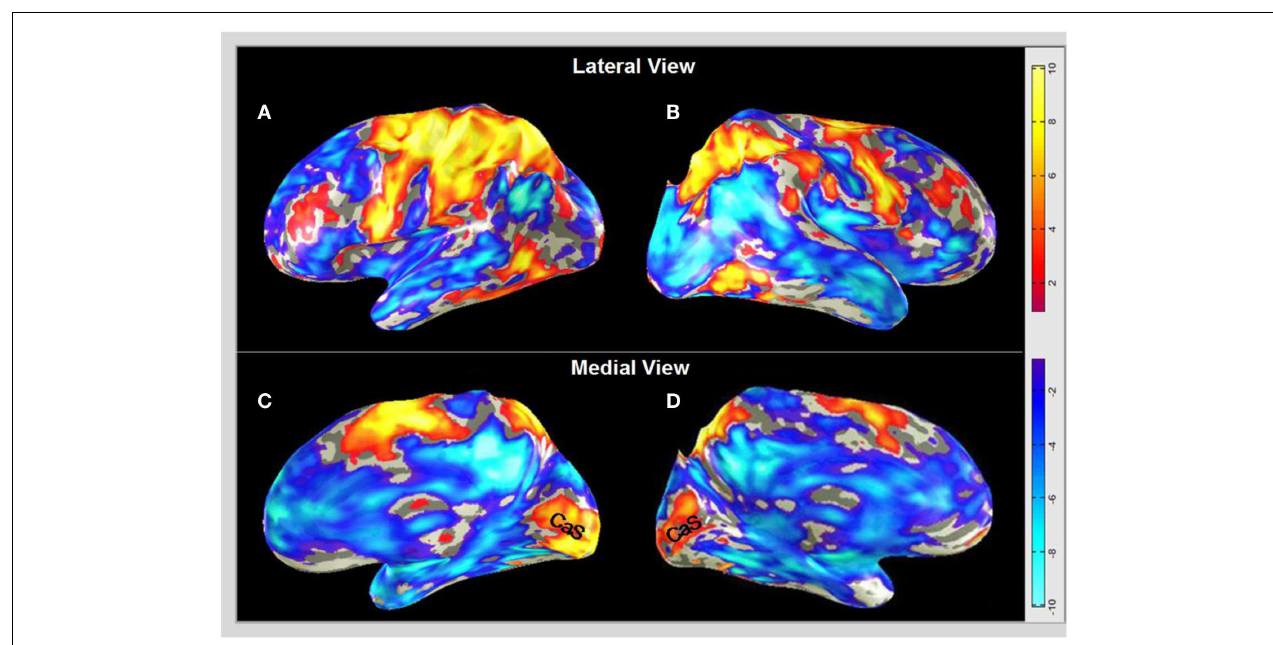
network that corresponds broadly to the default-mode network (except for the occipital lobe portion). (C,D) Both medial views show massive activation along the calcarine sulcus (CaS) corresponding toV1 surrounded by deactivation, which extends throughout the lateral regions of the visual cortex. Activation is shown down to − 1 < z < 1; the scale bar indicates the color-coding for the respective z-score levels. Note that, interestingly, the medial CaS activation spreads to the same eccentricity in both